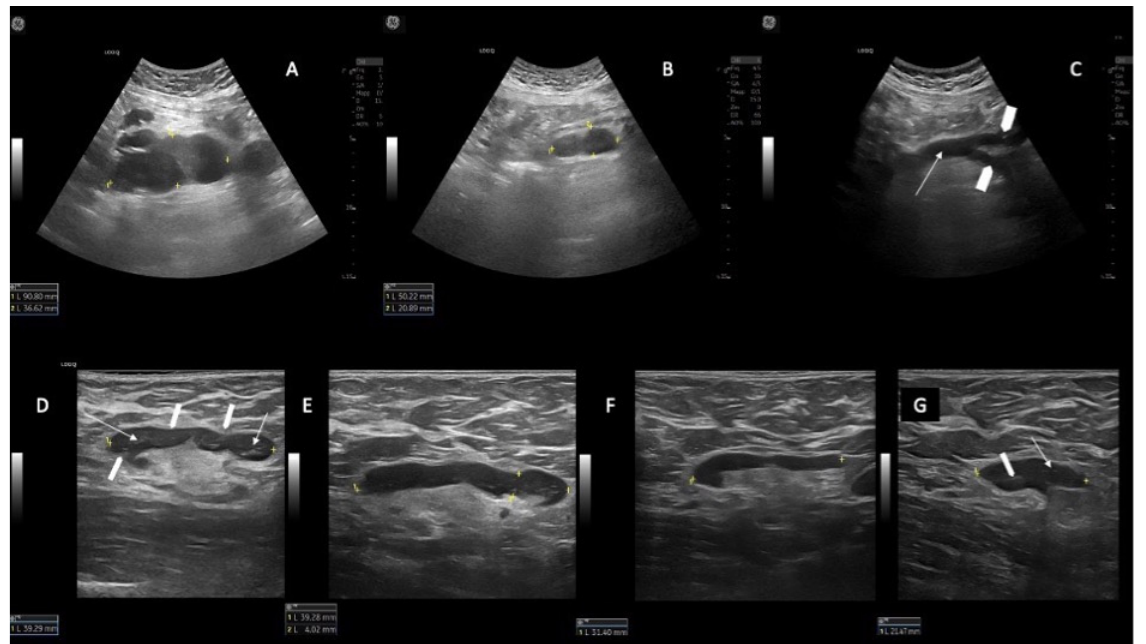
Figure 2. Example of AbdLN in CR but with persistence of CLL diseased SupLN (PR) in the same patient. ( A ) AbdLNs (longitudinal US scan with a convex probe) at baseline (T0) (90.1 mm). ( B ) the same AbdLN at T3 (50.2 mm). ( C ) disappearance of AbdLN (CR) at T6. The abdominal aorta is shown in a longitudinal scan (white arrow) and the right and left iliac arteries are visible (white arrowheads). ( D ) example of a right axillary CLL-SupLN at T0 (39.2 mm); the LN has an oval shape (long axis/short axis (L/S) > 2), the cortex is thickened, inhomogeneous, and reticulated (white arrows), which determines the lobular profile of the LN (white arrowheads). ( E – G ) the same right axillary CLL-SupLN at T6 (39.2 mm) ( E ), T12 (31.4 mm) ( F ) and T18 (21.5 mm) ( G ). In panel G there is still a partial involvement by CLL: the LN has oval shape (L/S > 2), the cortex is thickened and inhomogeneous and reticulated (white arrow), and the posterior part more thickened than the anterior part). The hilum is visible but is compressed and dislocated by the thickened cortex. Figure 3 shows the time to CR. We found that in patients who obtained nodal and splenic CR (N = 15), N = 13/15 (86.7%) patients reached a CR by 9 months from the begin- ning of the treatment.